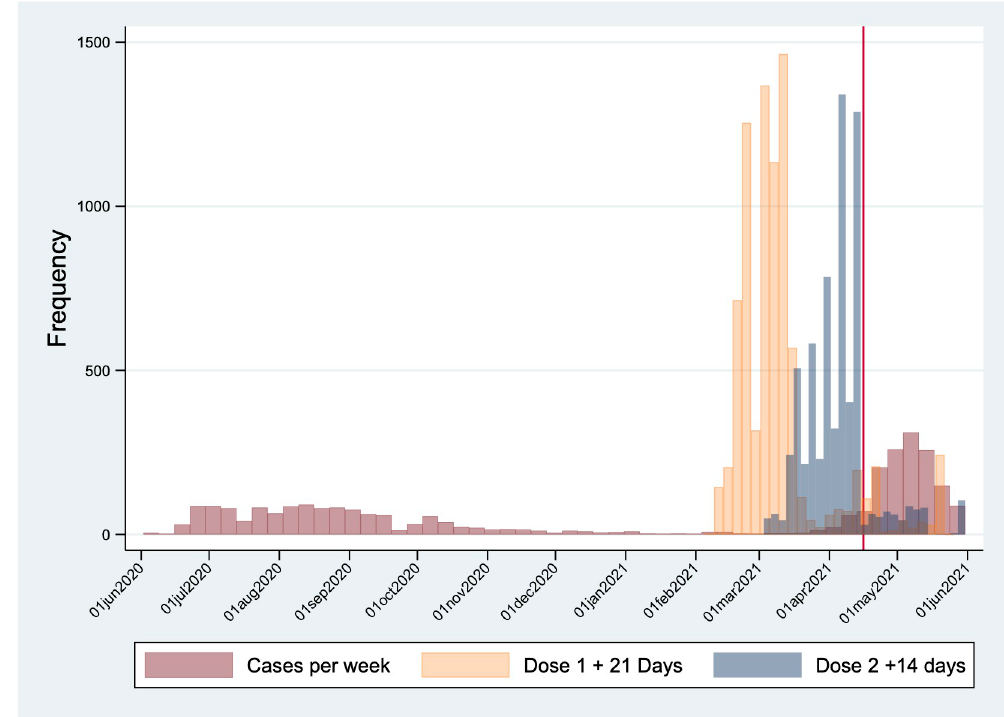
Fig 2. Temporal trends of COVID-19 infection and vaccination in our study cohort.